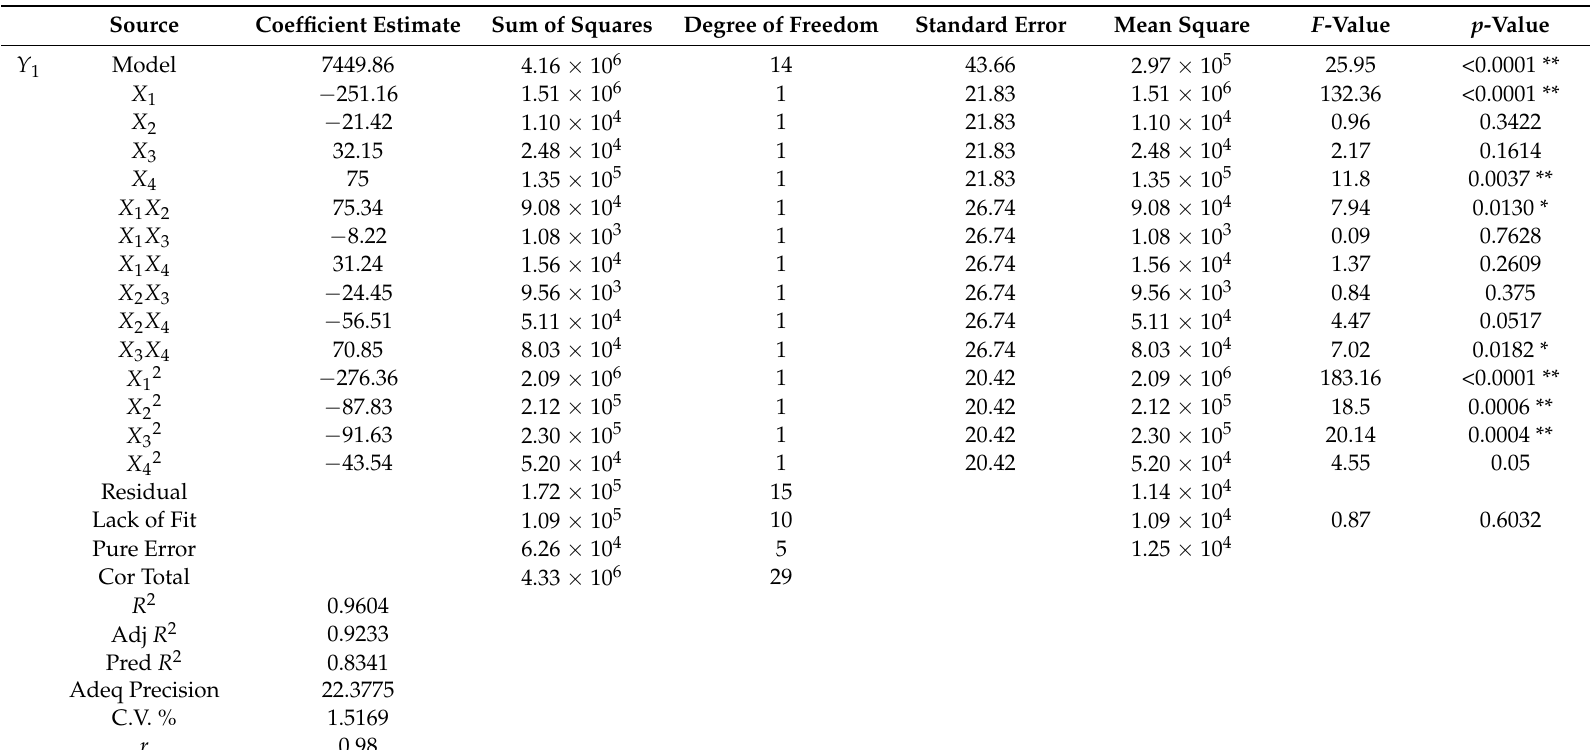
Table 2. Analysis of variance for the extraction of phenols yield ( Y 1 ) and antioxidant capacity ( Y 2